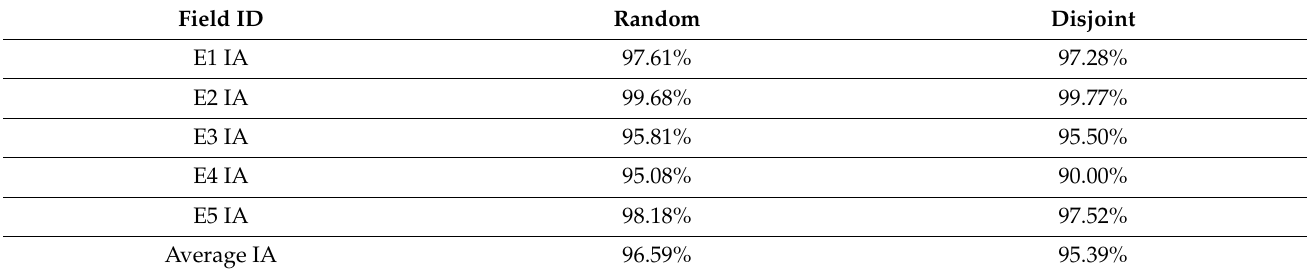
Table 8. Comparison between random sampling and spatially disjoint sampling on the field dataset.